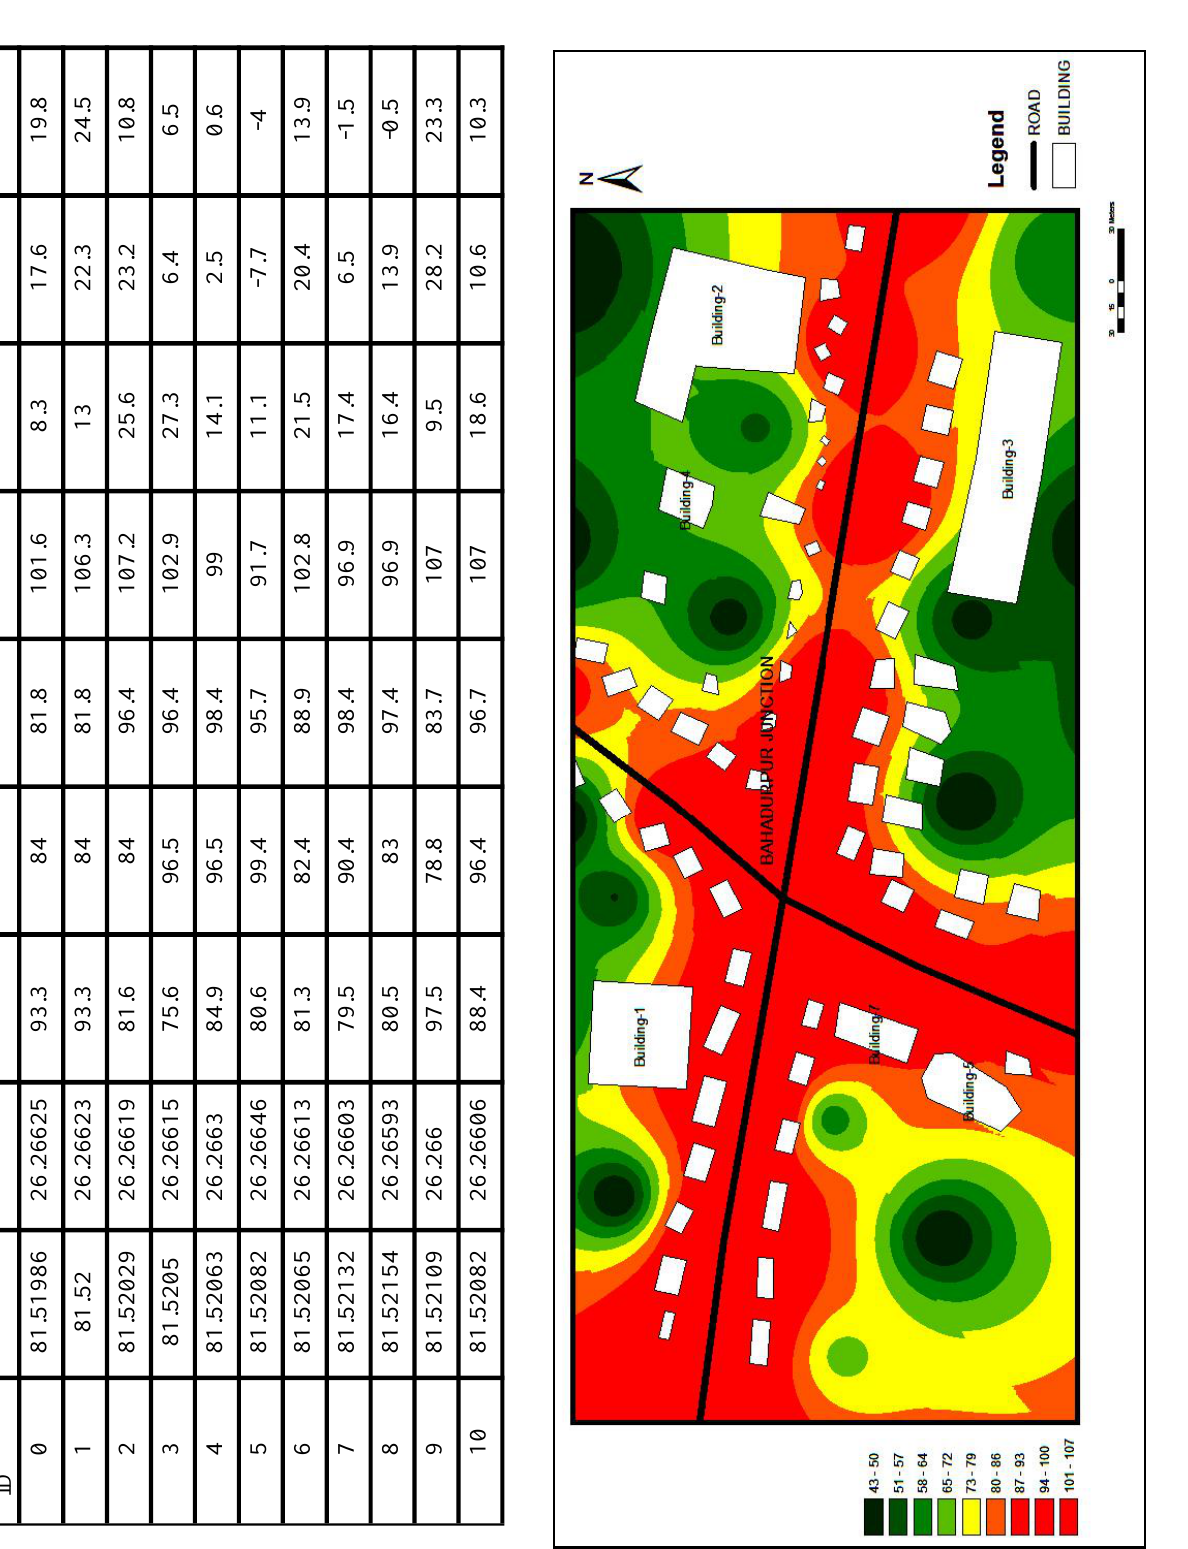
Table 2: The Short term and Instantaneous Average Noise Levels at Bahadurpur Crossing and their Variations Where, M1, M2, or M3 = 20 sec noise value at different time intervals; LEQ = 10 min noise Leq value at every point. LM1, LM2.LM3 = LEQ-(M1, M2, or M3), variation in the value of Leq for 10 minutes, and 20-seconds instantaneous scale.